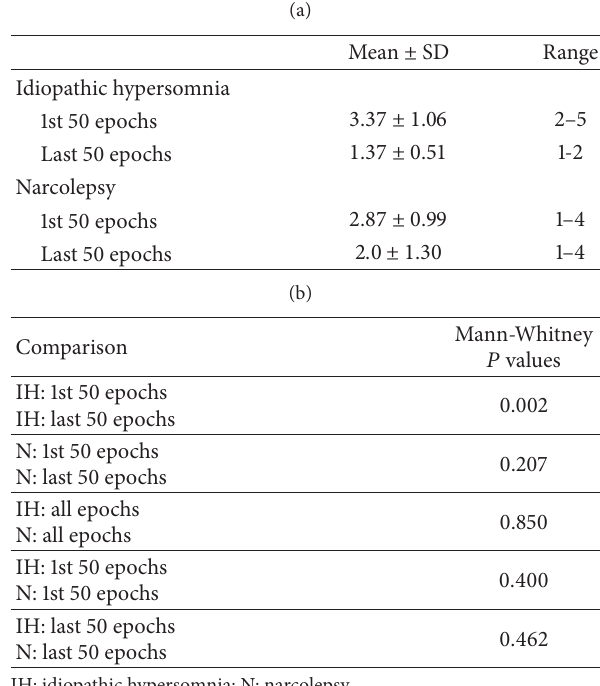
Table 3: (a) Number of continuous periods of N2 sleep evaluated in idiopathic hypersomnia and narcolepsy. (b) Intragroup and intergroup comparisons of the number of continuous periods of N2 sleep